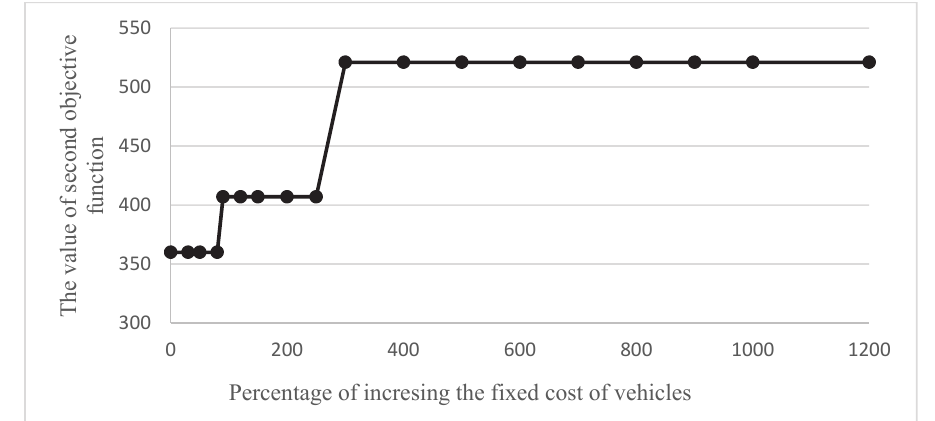
Fig. 7 . Impact of increasing the cost of vehicles on the second objective